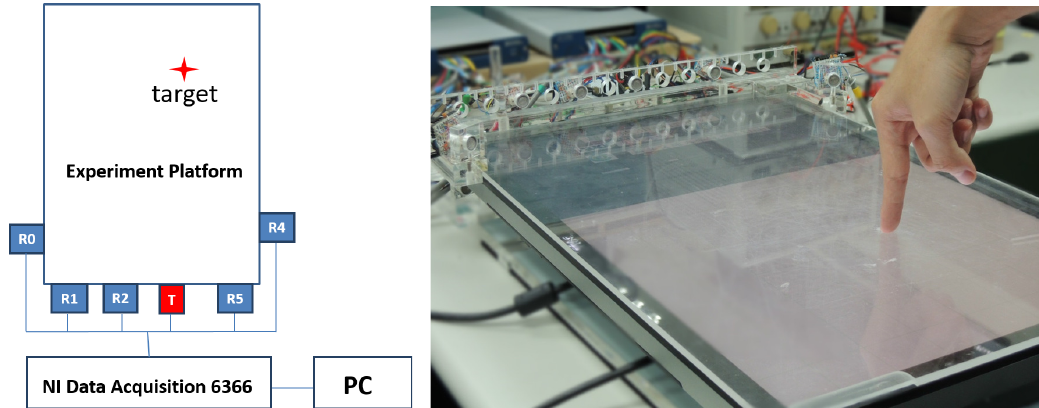
Figure 8. ( Left ): The architecture of the experimental system; ( Right ): The photo of the real experiment environment of the ultrasonic platform with the target as a human